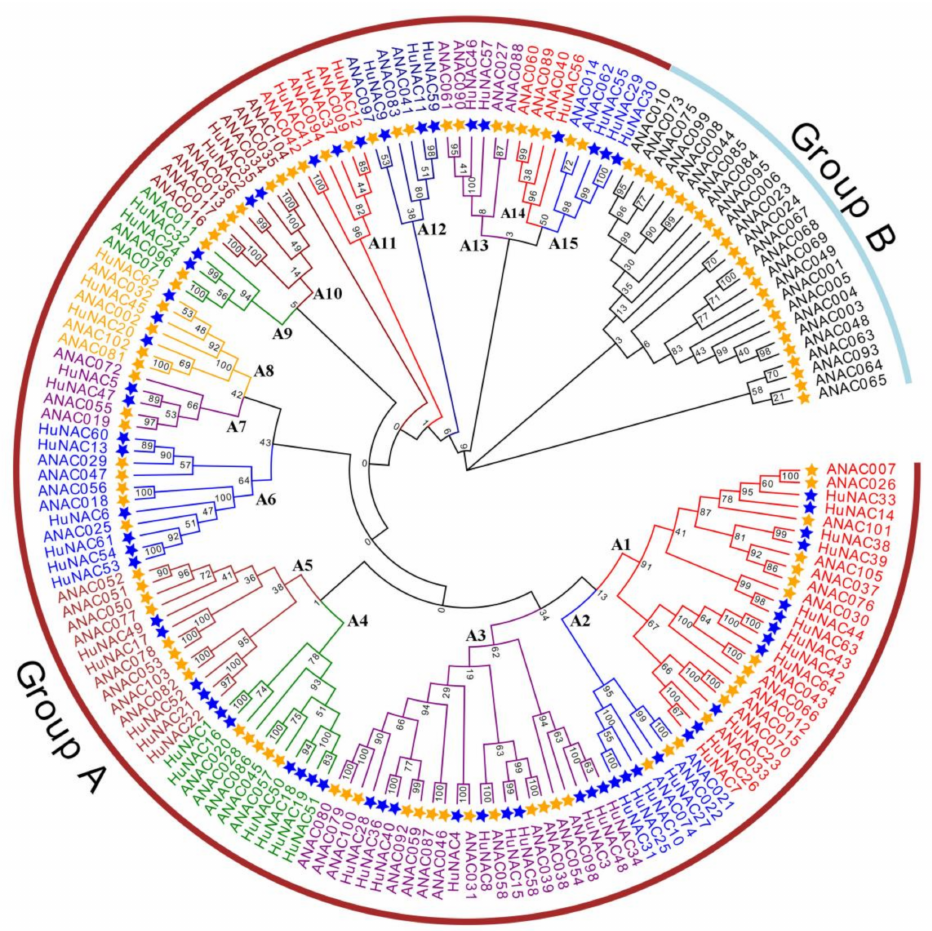
Figure 1. Phylogenetic tree analyses of NAC transcription factor family in pitaya (64 genes) and A. thaliana (105 genes). The full-length sequences of the NAC proteins were aligned using ClustalW, and the phylogenetic tree was constructed using the maximum-likelihood method in the MEGAX software. The Bootstrap value was 1000 replicates. HuNACs were indicated by blue stars. All members from both species were designated as Group A (A1-A15) and Group B. Each of the subfamily is indicated in a specific